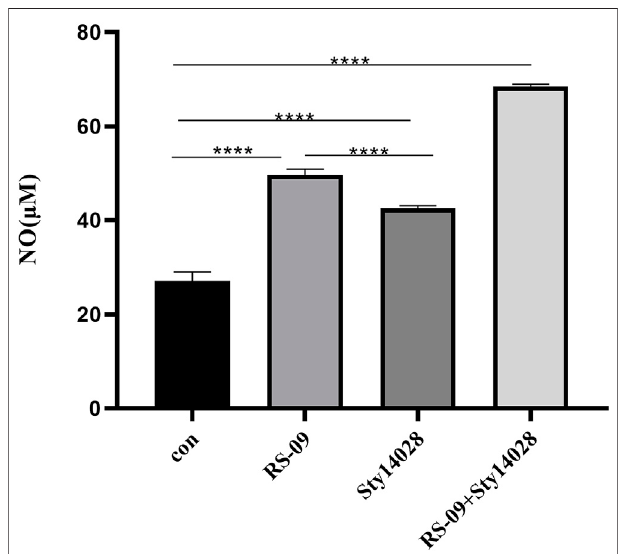
FIGURE 8 | Effect of RS-09 on nitrite (NO) production in bacteria- stimulated RAW264.7 macrophages. The content of NO in the culture supernatant was measured by the Griess reaction assay. The values represent the means ± SD of three independent experiments. **** p <